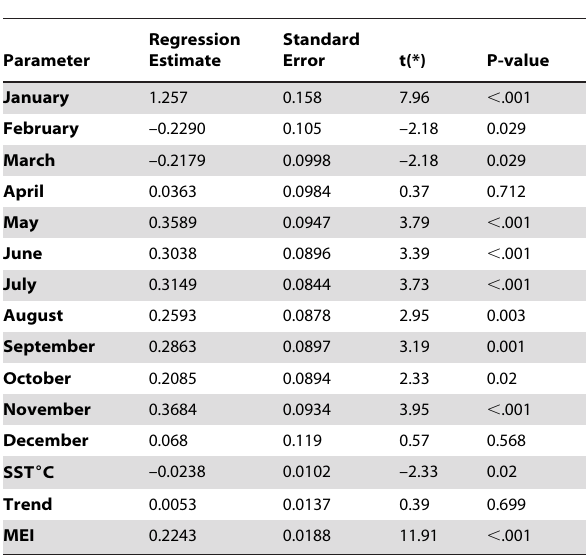
Table 8. The results of the generalized linear model when specific terms were omitted, for all sharks, females, and males, with the resulting Akaike Information Criterion values